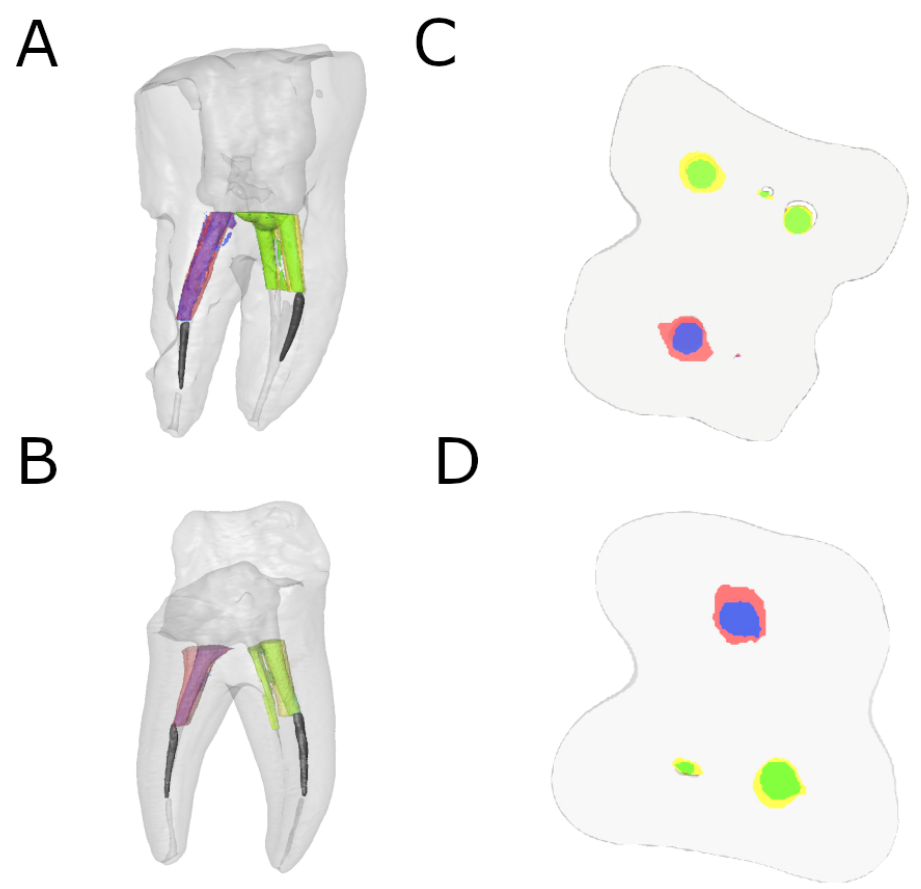
Figure 3. Reconstructed 3D micro-CT images of ( A ) preoperative and postoperative alignment and ( B ) cross-section of ER study group and reconstructed 3D micro-CT images of ( C ) preoperative and postoperative alignment and ( D ) cross-section of US study group. Preoperative (blue) and postoperative (red) distal root canal and preoperative (green) and postoperative (yellow) mesial root canals were aligned. The fractured NiTi endodontic rotary files (black) were also isolated in both distal and mesiobuccal root canal systems.